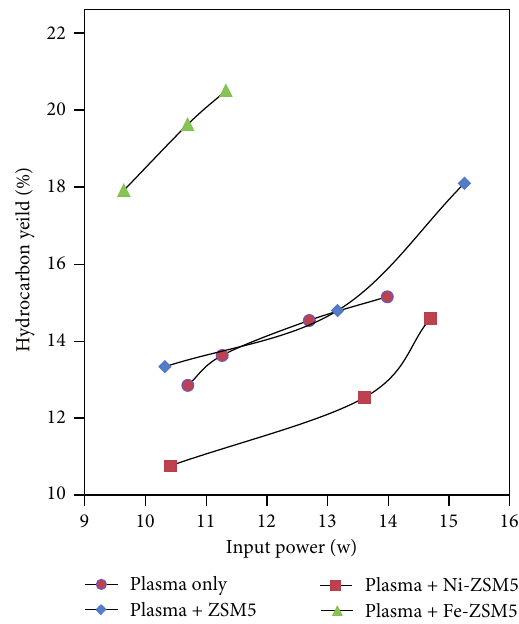
F 8: e yield of higher hydrocarbons versus input power supplied to the corona discharge